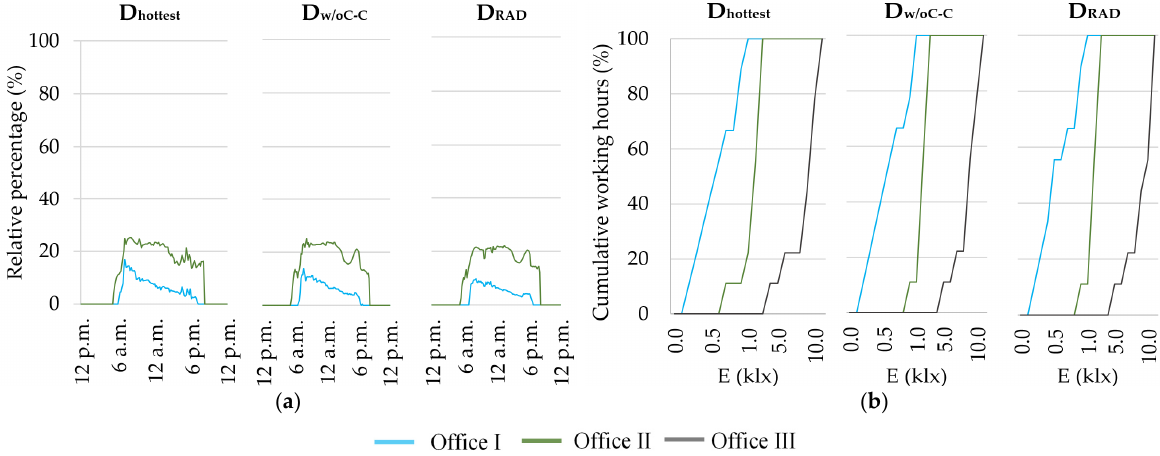
Figure 12. Indoor illuminance levels on the vertical plane in the office rooms for the cooling period representative days: ( a ) relative percentage (%) compared with the reference office room III without SCF; ( b ) cumulative frequency of working hours (9 a.m. to 6 p.m.) with less than certain levels of indoor illuminance, in %.